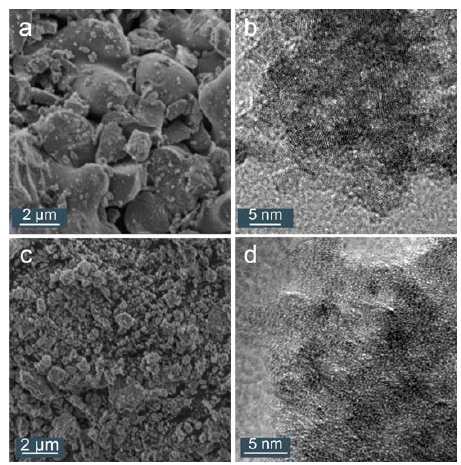
Figure 4. SEM images of pure ( a ) and 10% Sc-doped ( c ) TiO 2 ; TEM images of pure ( b ) and 10% Sc-doped ( d ) TiO 2 .